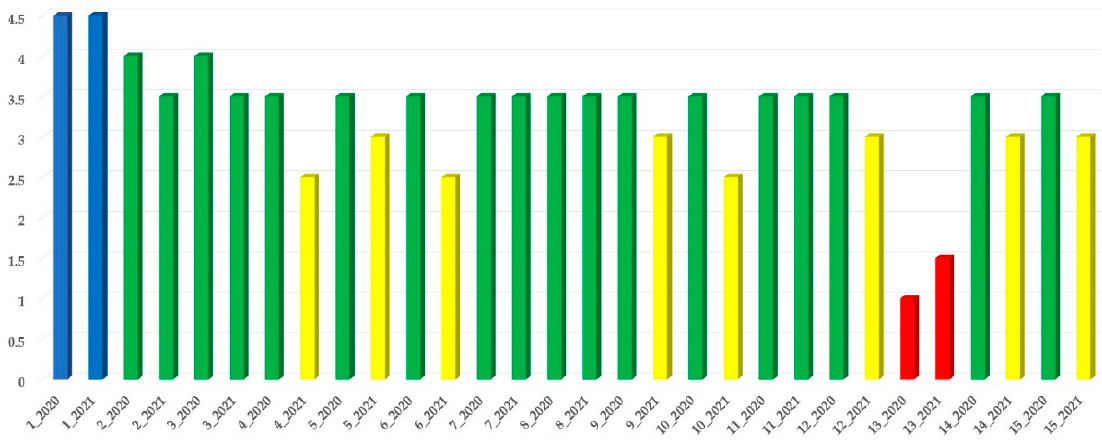
Figure 9. Ecological status assessment of the studied sites (blue, high; green, good; yellow, moderate; red, bad).